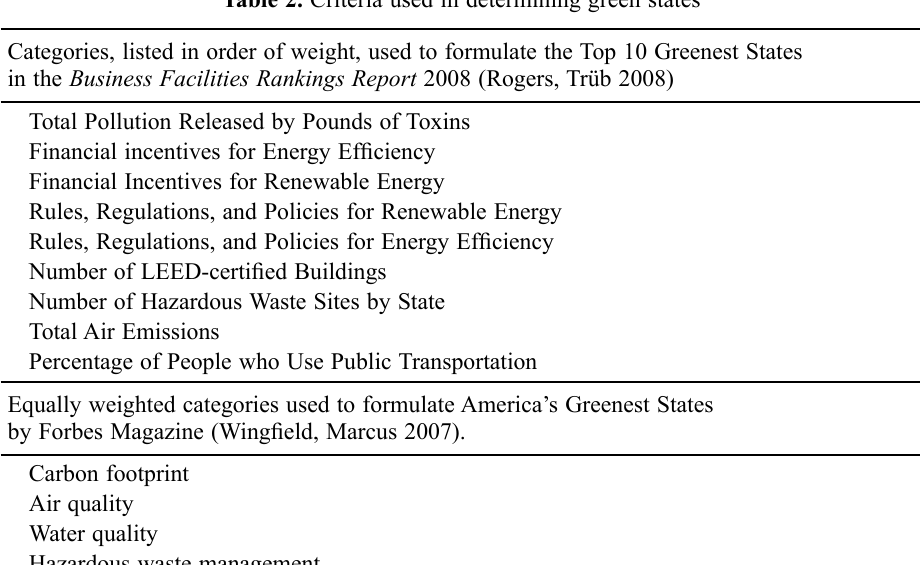
Table 2. Criteria used in determining green